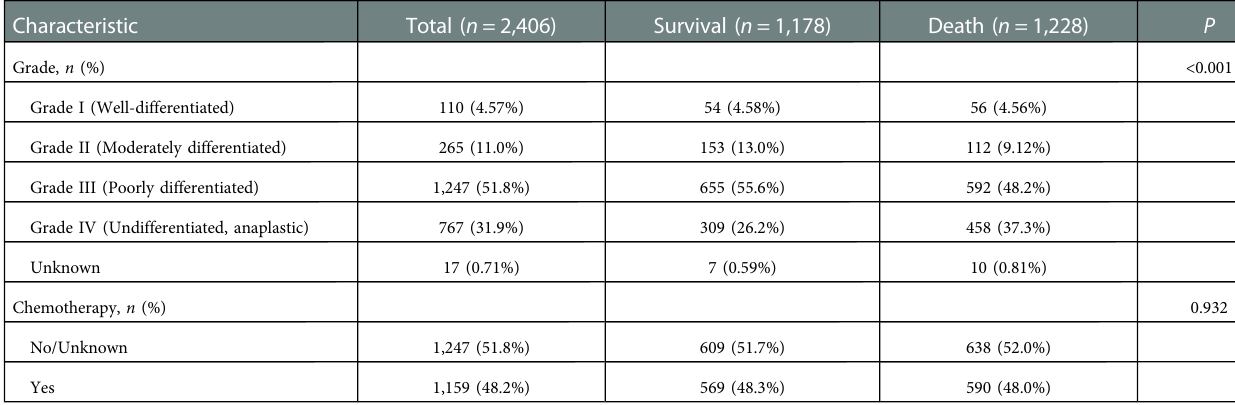
TABLE 2 Association between four staging system and OS of all participants using univariate and multivariate Cox proportional hazard models.